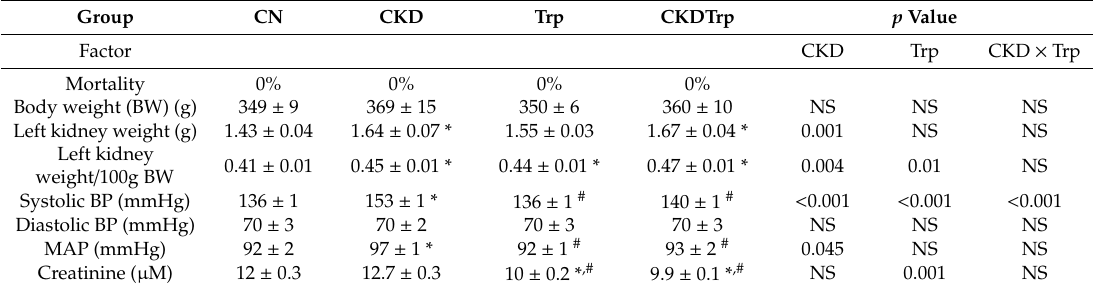
Table 1. Morphological and biochemical values in di ff erent experimental groups.